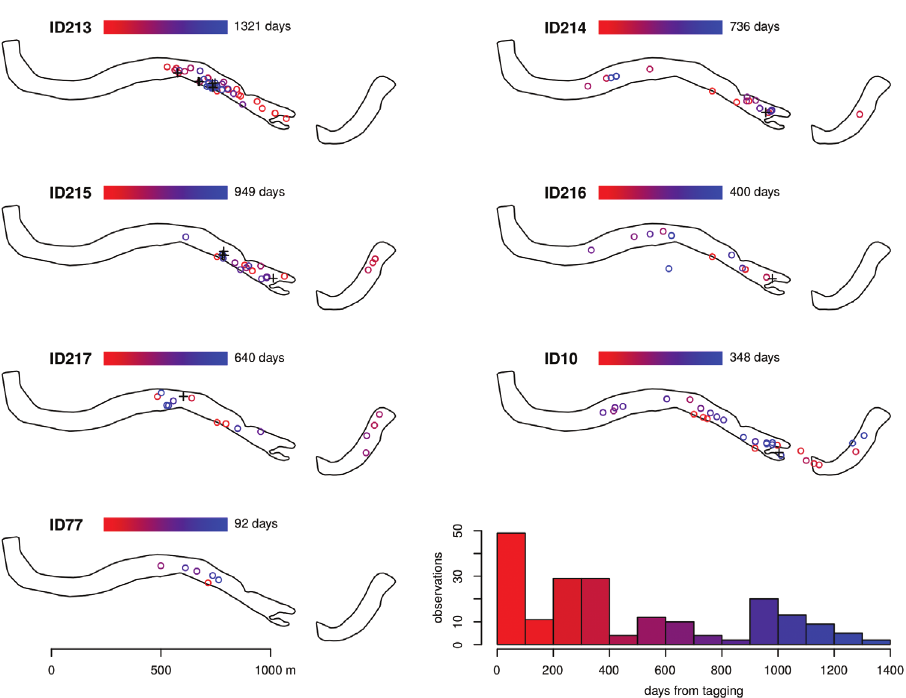
Figure 4. Representation of the locations (open circles) and hibernacula (crosses) of the tagged turtles in the Tajba NNR. The colour scheme represents the number of days elapsed from the day of